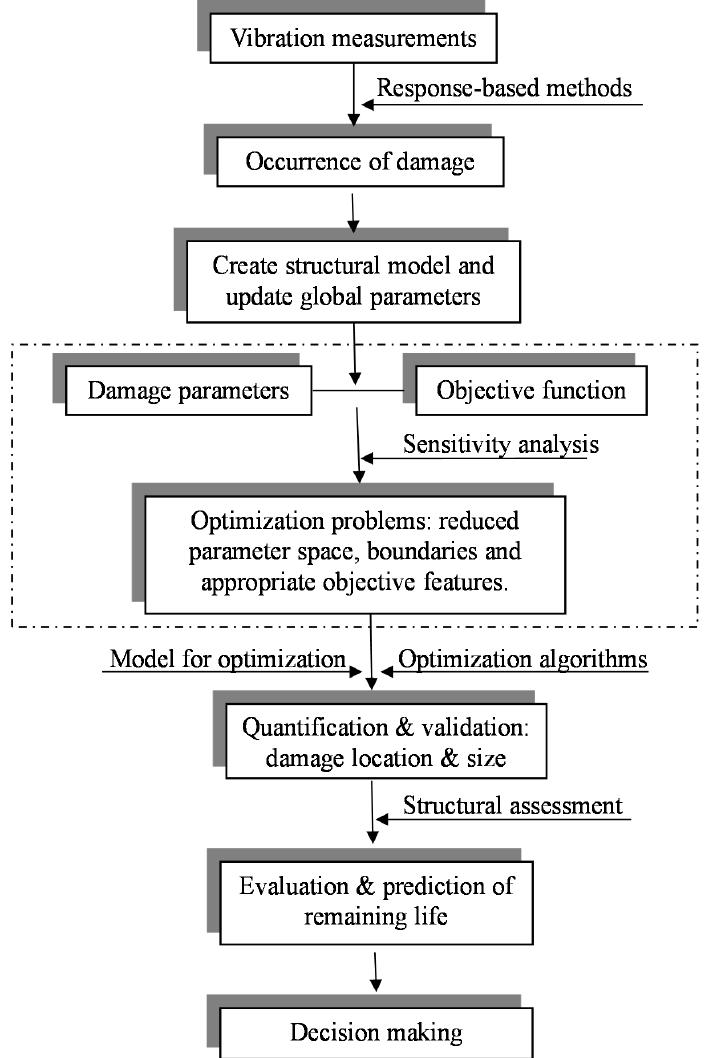
Figure 1. Flowchart of damage identification.